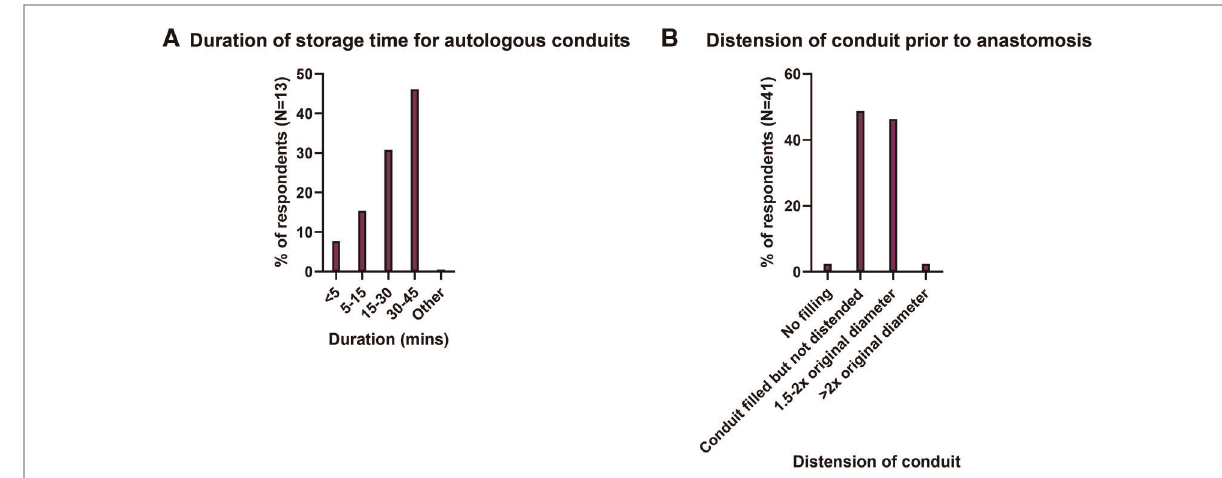
FIGURE 2 ( A ) Distribution of storage times for harvested autologous conduits and ( B ) Distension of conduit prior to